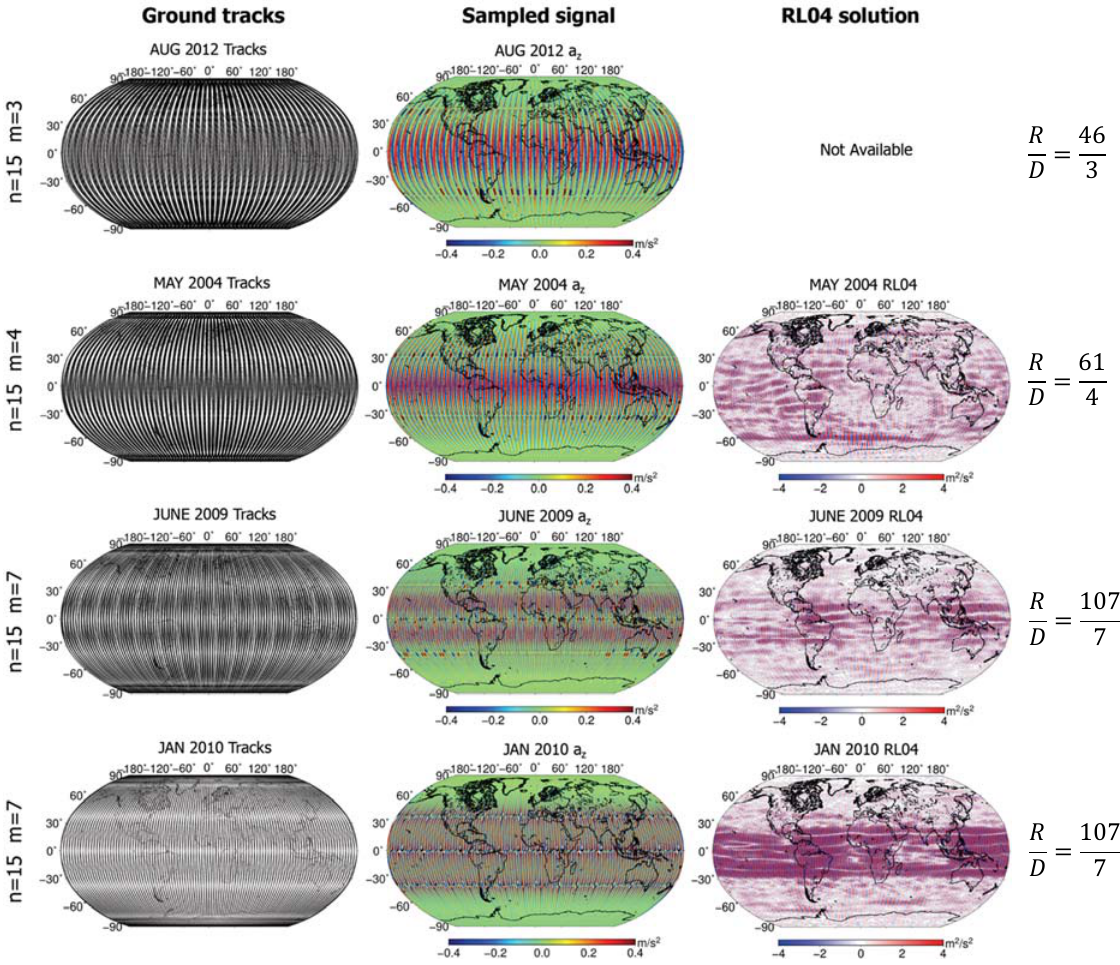
Figure 8. Left Panels: Ground tracks during various months when m takes typical values in the sub-Nyquist region; Middle Panels: Difference between GRACE-A and GRACE-B total gravity accelerations derived from the precise orbits (POD) of the two spacecraft along the z-axis. We note that the ratio m/n satisfies the condition 1 the upper limit (border-line artifacts). Right panels: GRACE RL04 gravitational potential (not available after 2012). R/D ratios are taken from [21].